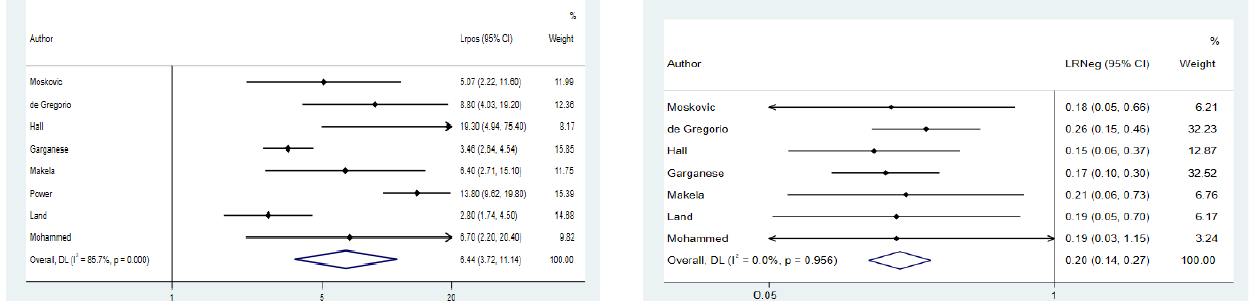
Figure 4. Forest plot for positive likelihood ratio and negative likelihood ratio.